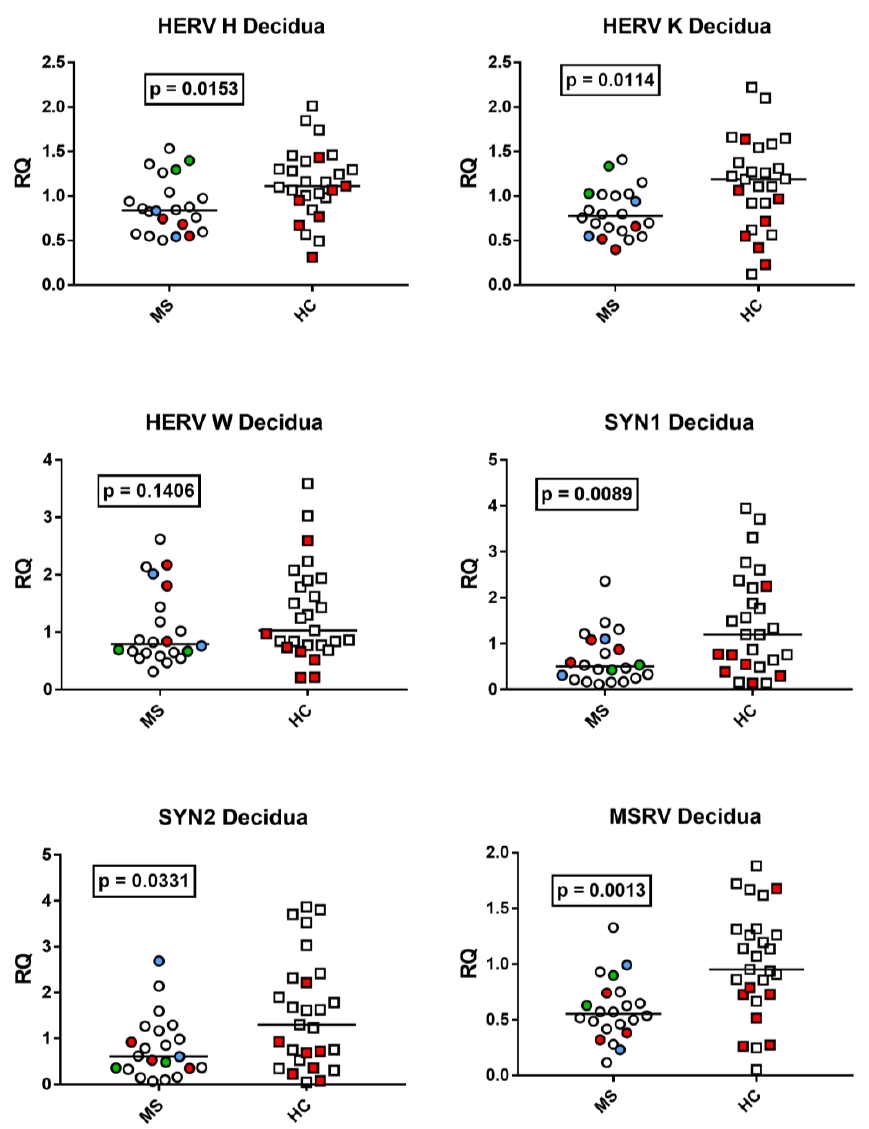
Figure 4. Expression of pol genes of HERV-H, -K, and -W and of env genes of Syncityn (SYN) 1, SYN2, and of multiple-sclerosis-associated retrovirus (MSRV) in the decidua basalis of 22 placentas from 20 mothers with multiple sclerosis (MS) and of 27 placentas from healthy control (HC) mothers. RQ: relative quantification. Circles and squares show the mean of three individual measurements; horizontal lines show the median values. Premature deliveries are shown in red; these include two pairs of dizygotic twins in blue and green. Medians and IQR 25–75%: HERV-H- pol Group A (mothers with MS) 0.84, 0.62–1.03; Group B (unaffected mothers) 1.11, 0.97–1.35; HERV-K- pol : Group A